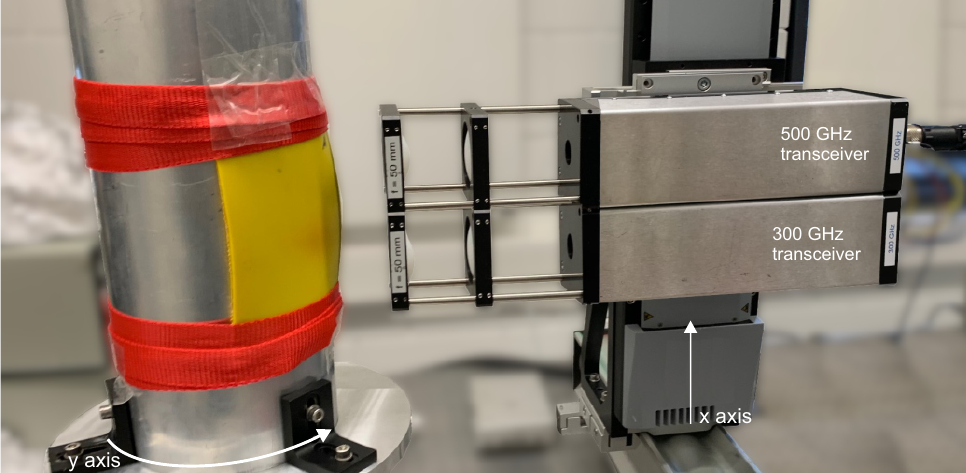
Figure 3. Laboratory-scale realization of the rotational imaging setup. Cut-out pieces of press sleeves are attached to a metal cylinder on a rotational stage. The two terahertz transceivers are mounted on a linear translational axis pointing towards the rotational axis of the metal cylinder. By linear translation along the cylinders axis, terahertz data is recorded on a spiral imaging